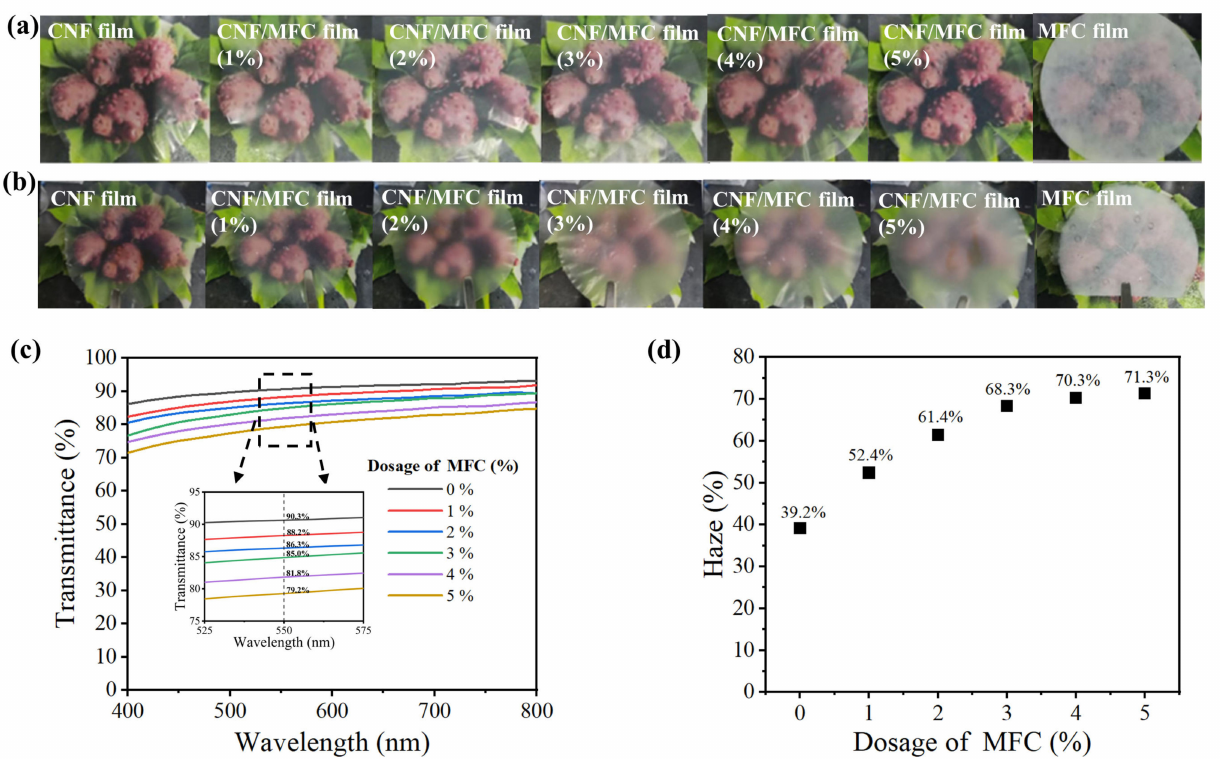
Figure 3. Digital images of CNF film, composite films with different dosage of MFC (1–5 wt.%) and MFC film (the tunicates are covered by the films) ( a ); Digital images of cellulose films (the distance between cellulose films and tunicates is 6 cm ( b ); Light transmittance ( c ) and haze ( d ) of cellulose films with different dosage of